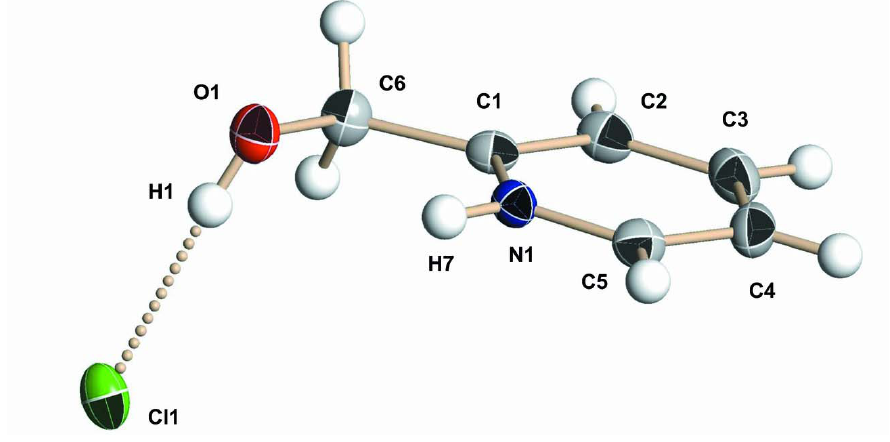
Figure 1 The molecular structure of the title compound, with atom labels and 50% probability atomic displacement ellipsoids for non-H atoms. The Cl atom has been translated to clarify interaction with the OH group.